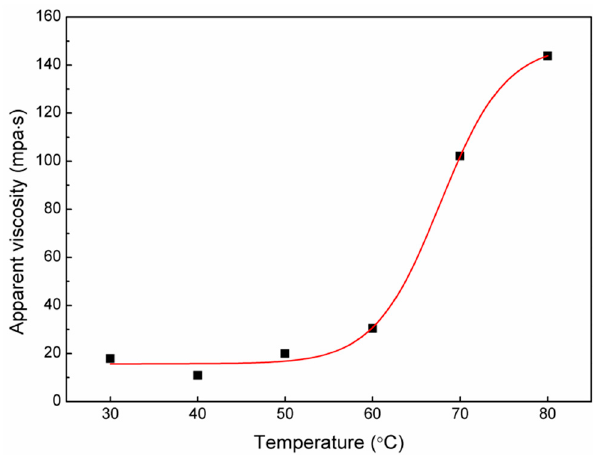
Figure 2. Dependence of extraction temperature of apparent viscosity of RBPs at 10 s − 1 , C RBP , was 2.0